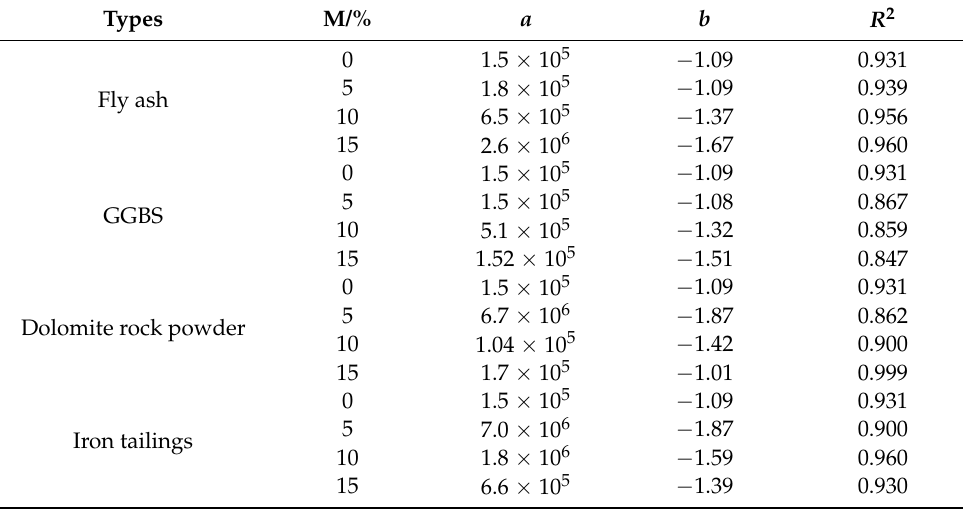
Figure 5. Correlation between concrete electric flux and resistivity. Table 5. The fitting results between electric flux and electrical resistivity of